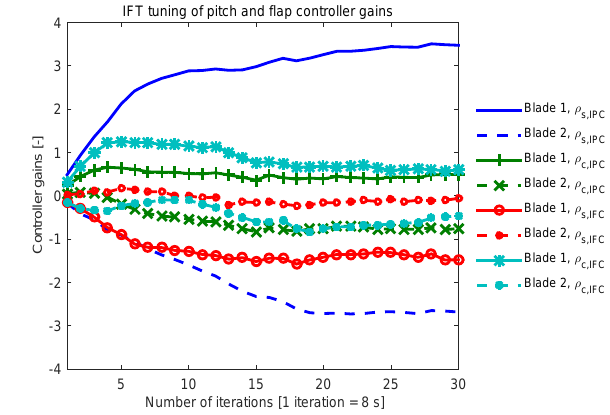
Figure 15. Convergence of controller gains over iterations.